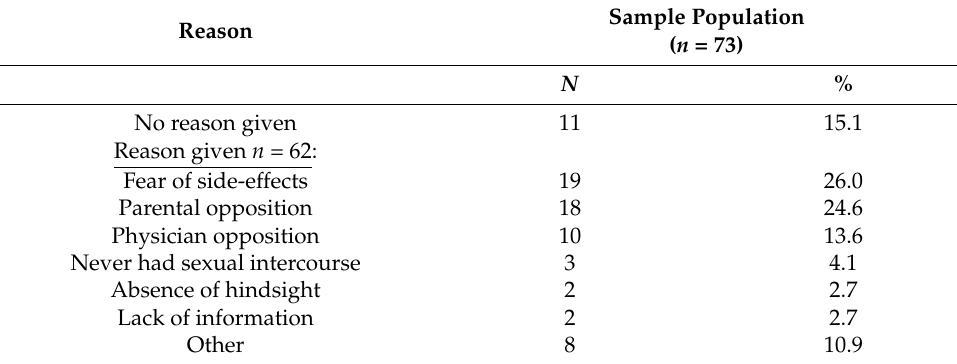
Table 3. Reasons given for refusal of